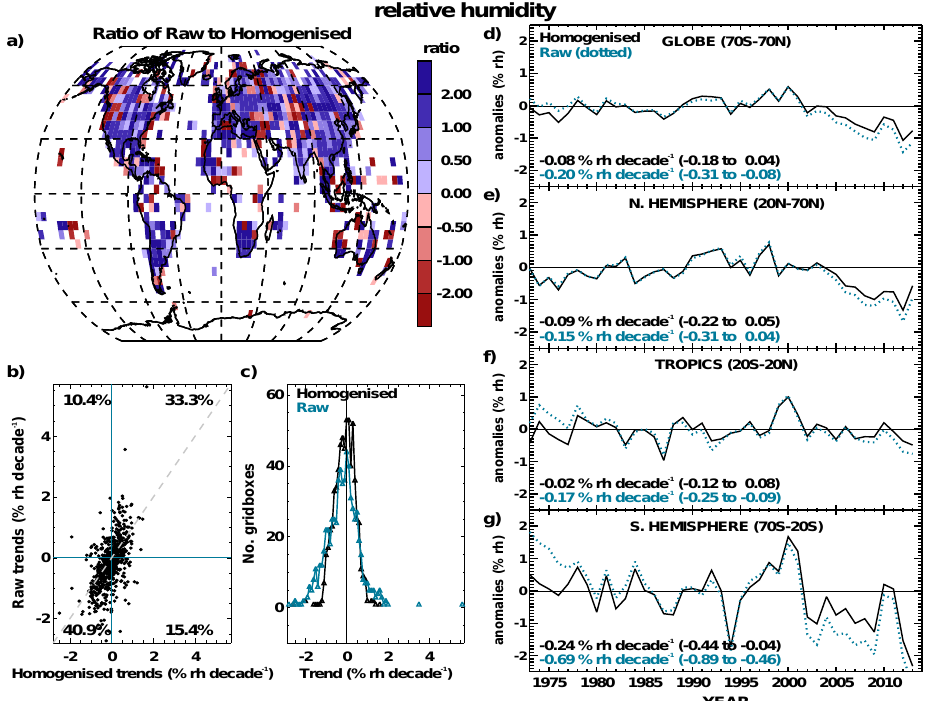
Figure 10. Comparison of decadal trends from 1973–2013 between raw and homogenised monthly mean relative humidity. (a) Ratio of raw to homogenised trends for each grid box (a value of > 1 means that the raw trend is greater than the homogenised trend). (b) Scatter plot of raw verses homogenised decadal trends for each grid box with percentage presence in each quadrant. (c) Trend size distribution for raw and homogenised grid boxes. (d) Large-scale area-average time series (weighted by the cosine of the latitude) and decadal trends calculated using the median of pairwise slopes with 5th to 95th percentile slopes as confidence